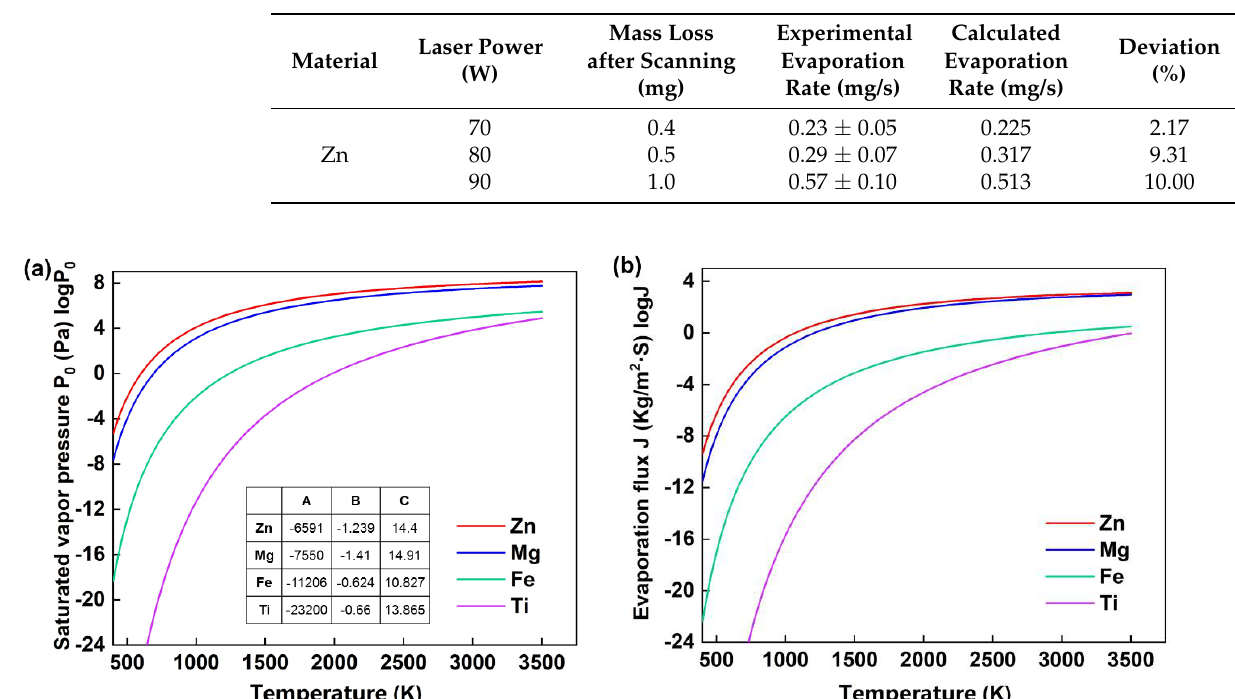
Figure 6. Flow behavior inside the molten pool, as determined by calculation for P = 90 W V = 500 mm/s, ( a ) TC4, ( b ) pure Zn. Table 1. Evaporation rate by experiment and calculation.